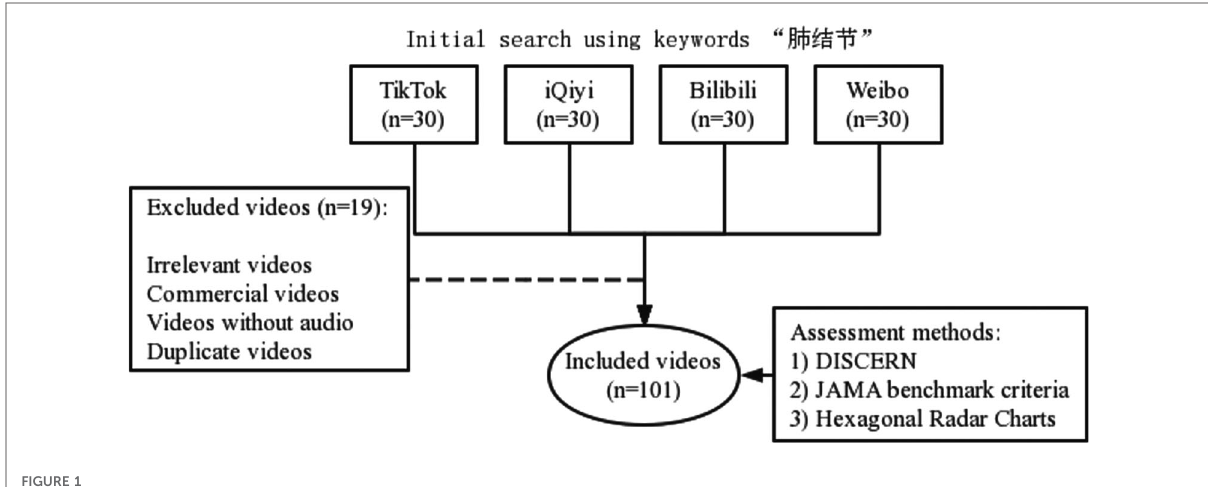
FIGURE 1 Flowchart of video selection.